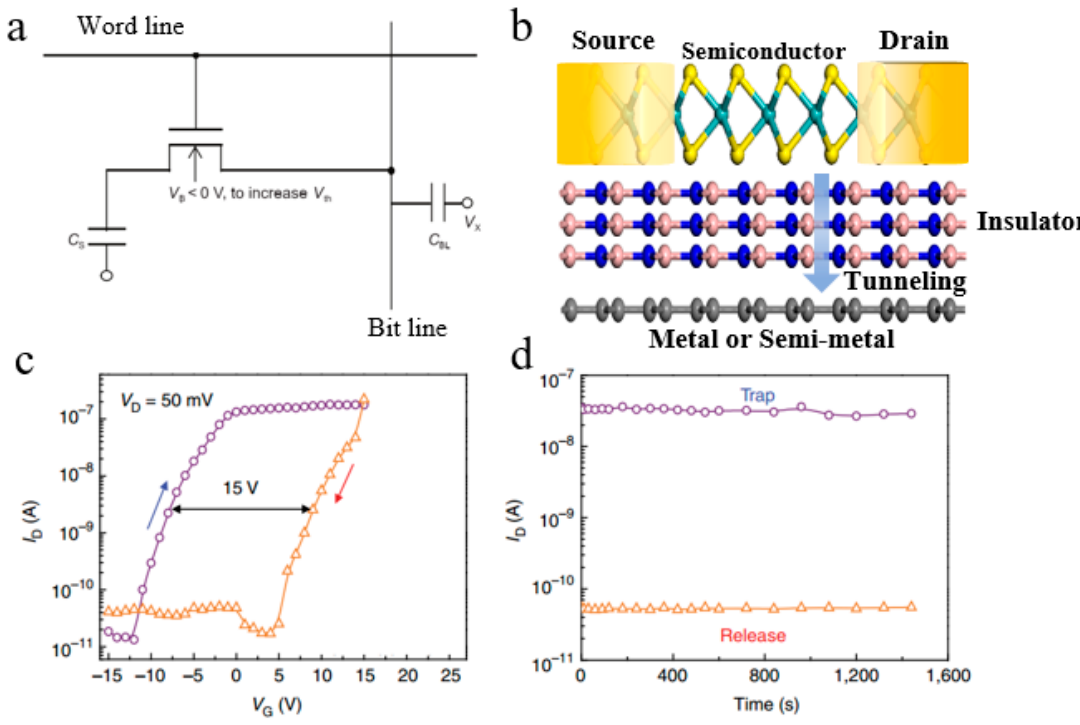
Figure 10. Schematic diagram of different type of memory and performance curve: ( a ) 1T1C structure of dynamic random access memory; ( b ) semiconductor–insulator–metal heterostructure of flash memory; ( c ) gate hysteresis curve of flash memory; ( d ) stability and endurance of flash memory. ( c , d ) are reproduced with permission from Nature Publishing Group, Ref [113].